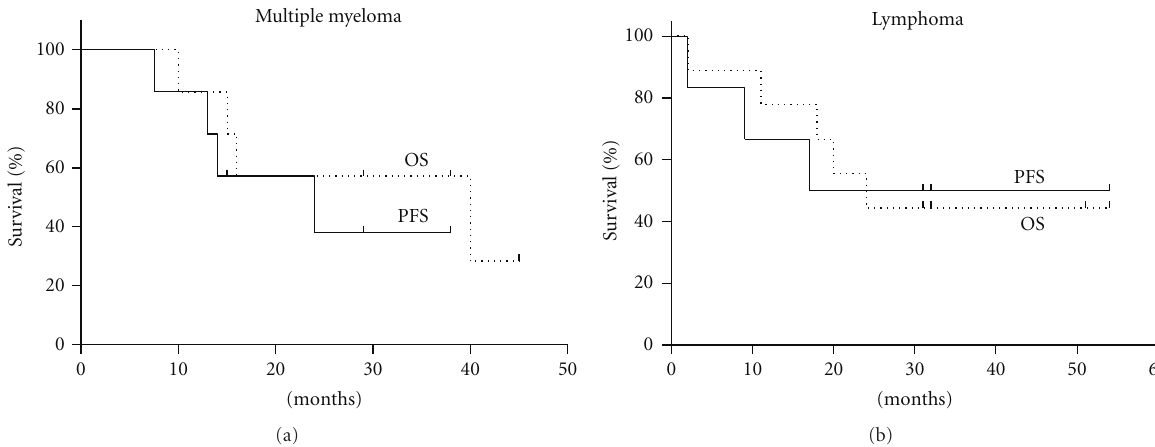
Figure 1: The Kaplan-Meier curves for PFS (solid line) and OS (broken line) for MM patients (a) and lymphoma patients (b). The data shown is only for the poor mobilizer